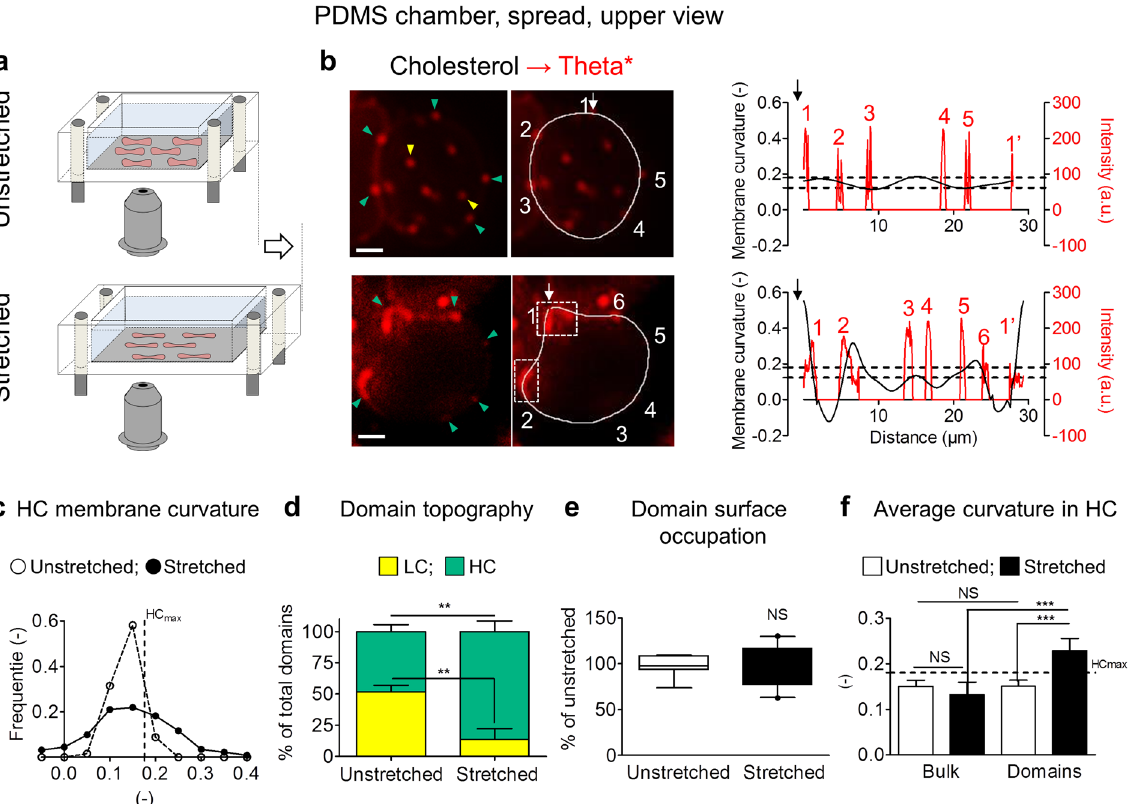
Figure 4. Recruitment of chol-enriched domains in increased curvature areas of the RBC rim upon stretching. Fresh healthy RBCs were labelled with Theta * , washed and spread onto PLL-coated polydimethylsiloxane (PDMS) chamber and directly visualized by vital fluorescence microscopy before ( unstretched ) and after stretching ( stretched ). ( a ) Schematic representation of the stretching system. ( b ) Representative imaging ( left & central panels ) and comparison of Theta * intensity ( red ) and membrane curvature ( black ) profiles ( right panel ). Y ellow and green arrowheads indicate LC and HC membrane areas, respectively. Profiles are done along paths indicated in central panel by white curved lines starting by white arrows ; domains ( red numbers ) are labelled with white numbers in central panel ; dashed lines represent HC min and HC max . Theta * -labelled domains associated with increased curvature ( > HC max ) are boxed in central panel . Representative of two independent experiments, s cale bars 2 µ m. ( c ) Quantification of curvature value distribution of HC membrane calculated on profiles of unstretched ( open symbols) and stretched RBCs ( black symbols ). ( d , e ) Quantification of domain topography (d; number by hemi- RBC, expressed as percentage of total domains) and surface occupation (e; total domain area by hemi-RBC area, expressed as percentage of unstretched). ( f ) Quantification of average curvature values of HC bulk membrane and domains. Results are means ± SEM of 13–18 RBCs from two independent experiments. Statistical significance was tested with two-sample t-tests, except one-way ANOVA followed by Tukey’s post-hoc test in